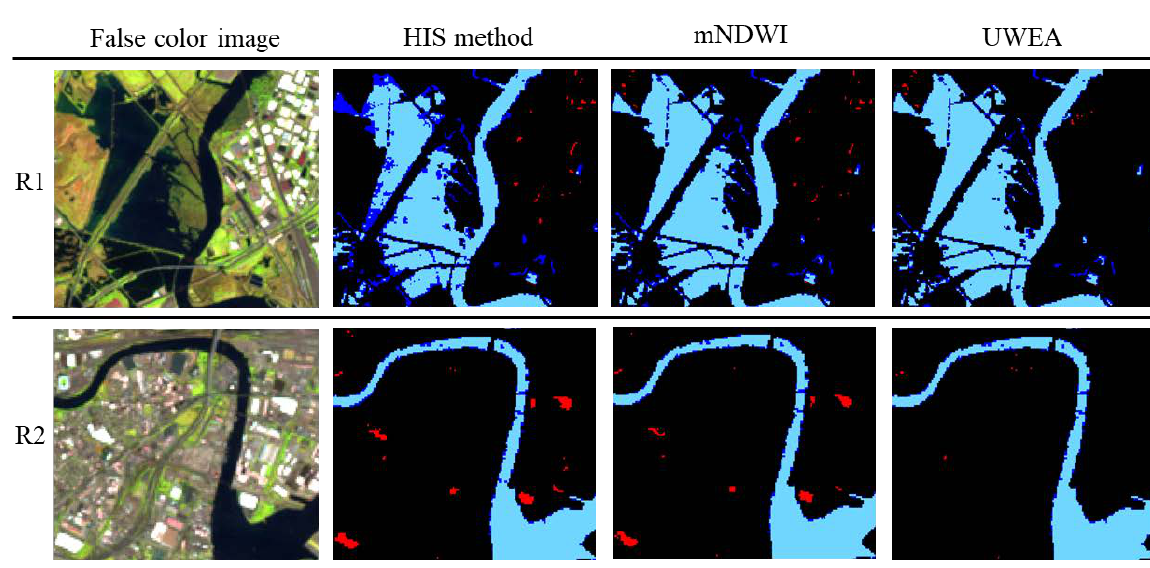
Figure 9. The same as Figure 7 but for New York.